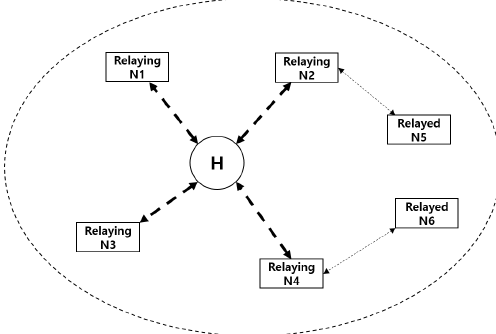
Figure 5. Two-hop star network